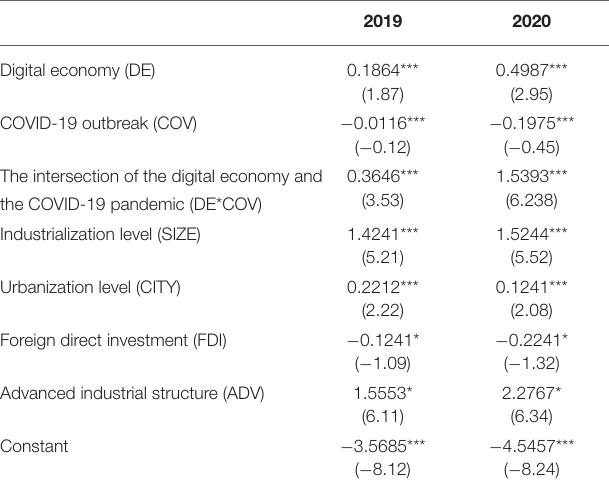
TABLE 5 | Indirect impact of COVID-19 pandemic and the digital economy on level of economic development of China.